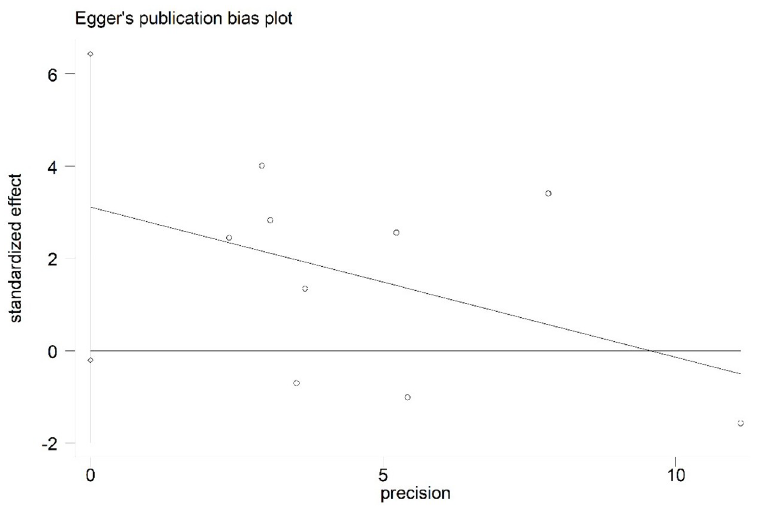
Fig 12. Egger’s publication bias plot for postpartum mood